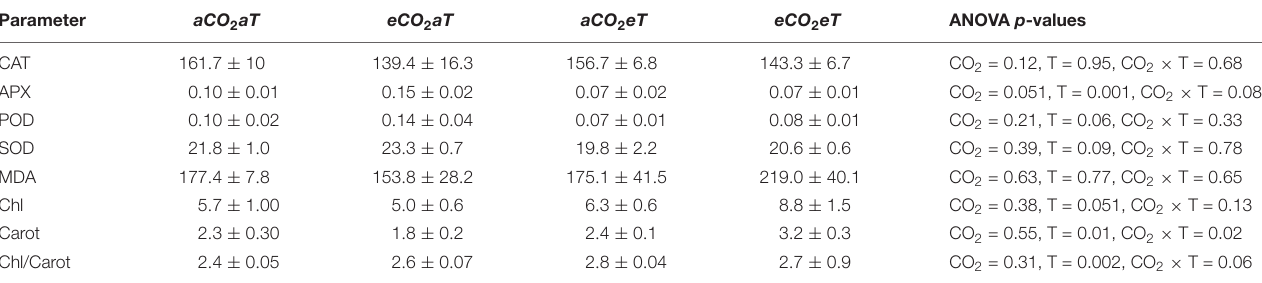
TABLE 2 | Biochemical parameters in leaves of S. capitata exposed to elevated levels of atmospheric [CO 2 ] and temperature at the Trop-T-FACE facility at 66th day of experiment.